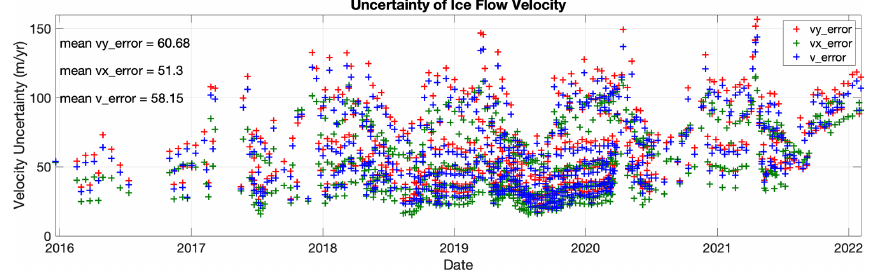
Figure 22. Uncertainty in ITS_LIVE Sentinel-1 image-pair velocities shown in Fig. 21 as provided in the products. The vx, vy and v uncertainties are calculated according to Eq.